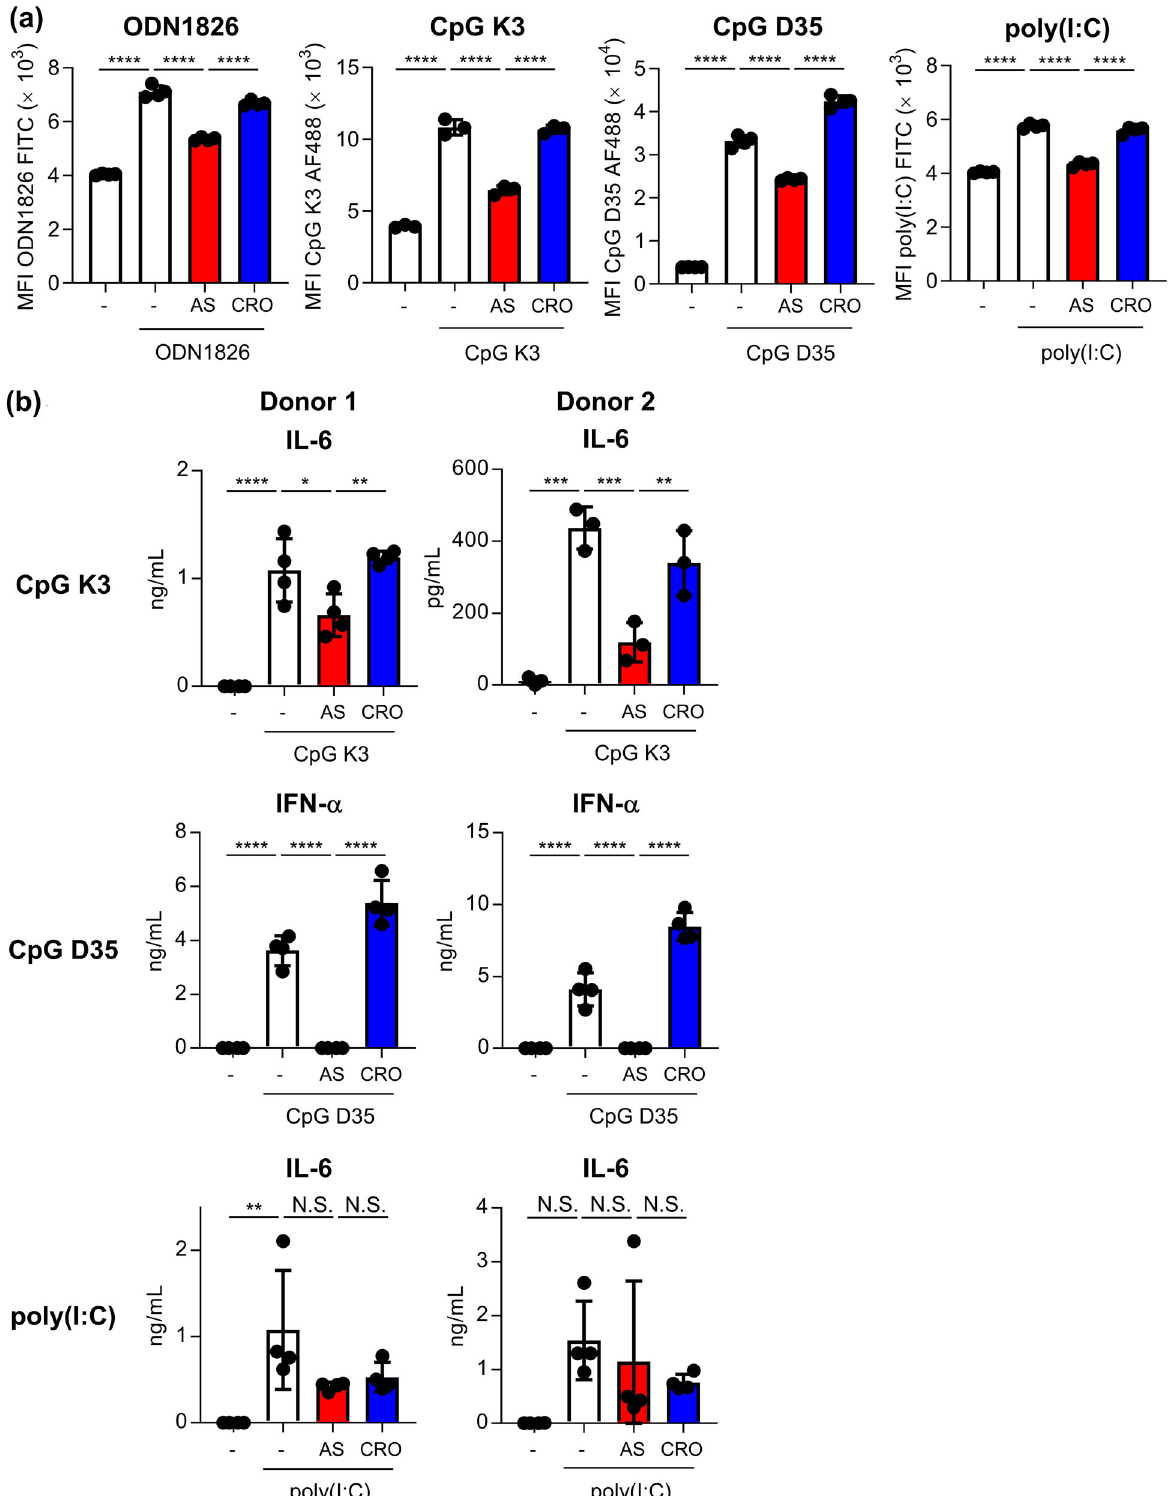
Fig. 6 Contribution of nucleolin on CpG ODN- and poly(I:C)-mediated internalization into human DCs and cytokine production from human PBMCs. a CAL-1 cells were treated with 10 μ g/mL FITC-labeled ODN1826, 10 μ g/mL Alexa 488-labeled CpG K3, 10 μ g/mL Alexa 488- labeled CpG D35 or 5 μ g/mL FITC-labeled poly(I:C) with or without 5 μ M AS1411 or 5 μ M CRO at 37 °C for 30 min. Internalization into CAL-1 cells was measured by fl ow cytometry after trypan blue quenching. b Human PBMCs were treated with 1 μ g/mL CpG K3, 10 μ g/mL CpG D35, or 1 μ g/mL poly(I:C) with or without AS1411 (1 or 5 μ M) or CRO (1 or 5 μ M) at 37 °C for 24 h. The concentrations of IL-6 and IFN- α in the supernatants were then measured by ELISA. N.S.: not signi fi cant. a , b Each experiment was performed more than twice. Data are shown as the means ± SD. * P < 0.05, ** P < 0.01, *** P < 0.001, **** P < 0.0001 by Tukey ’ s